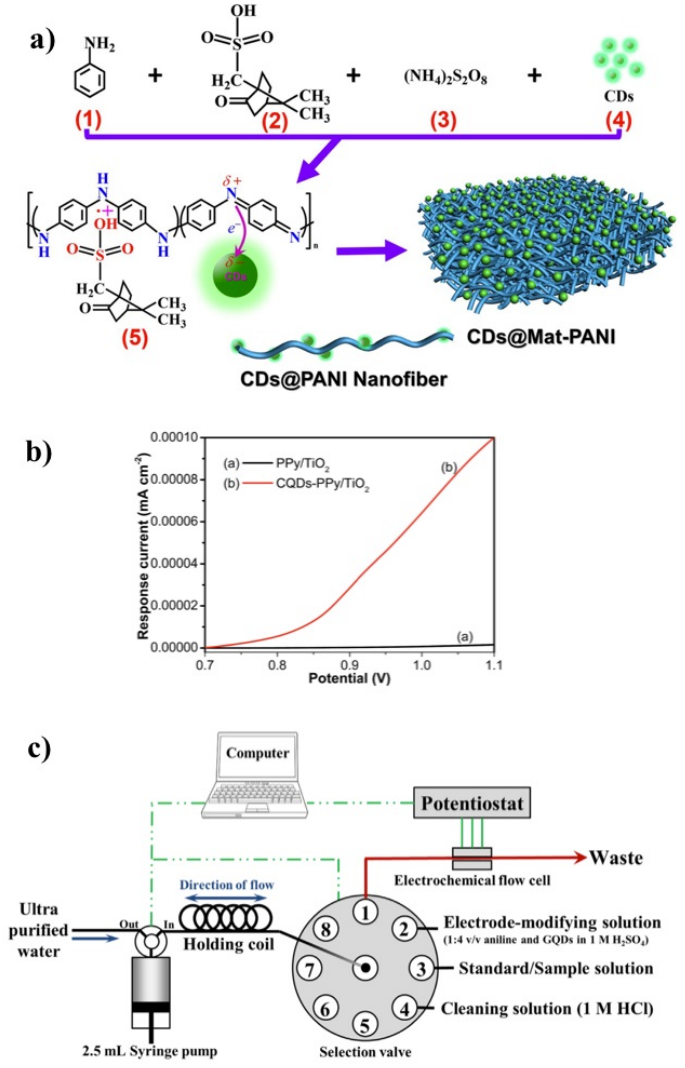
Figure 6. ( a ) Schematic diagram of the synthesis procedure of CDs@Mat-PANI. Adapted